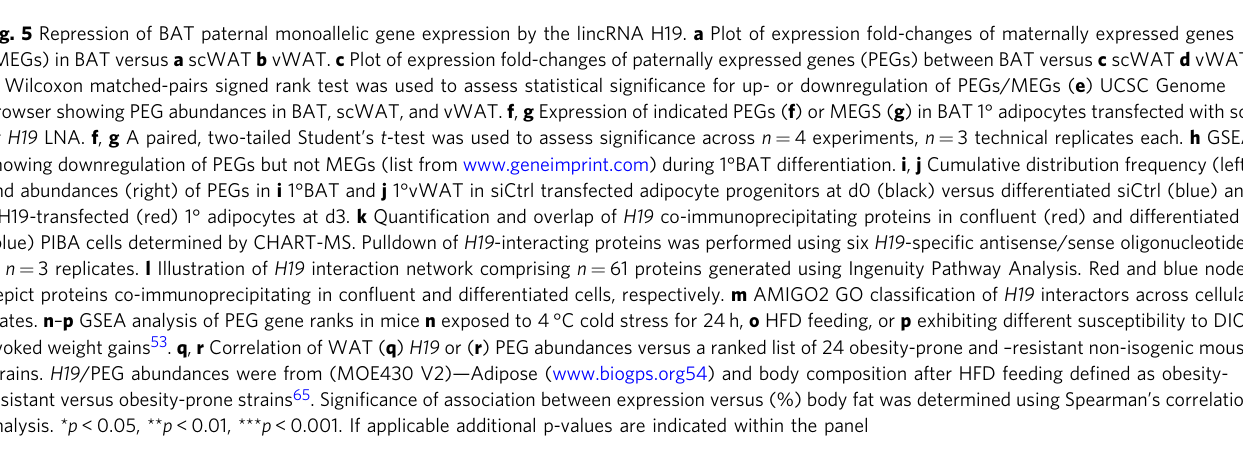
depict proteins co-immunoprecipitating in con fl uent and differentiated cells, respectively. m AMIGO2 GO classi fi cation of H19 interactors across